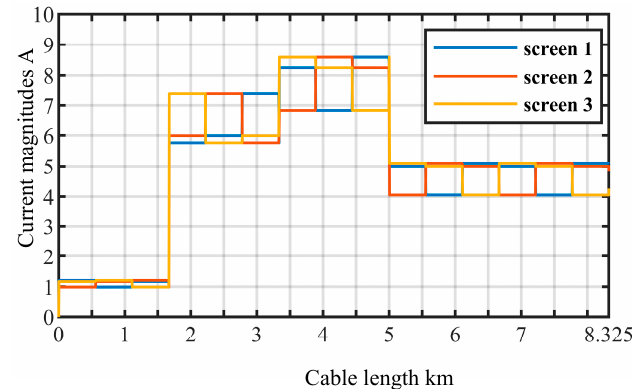
Figure 7. Induced current magnitudes in the three screens for case #1.